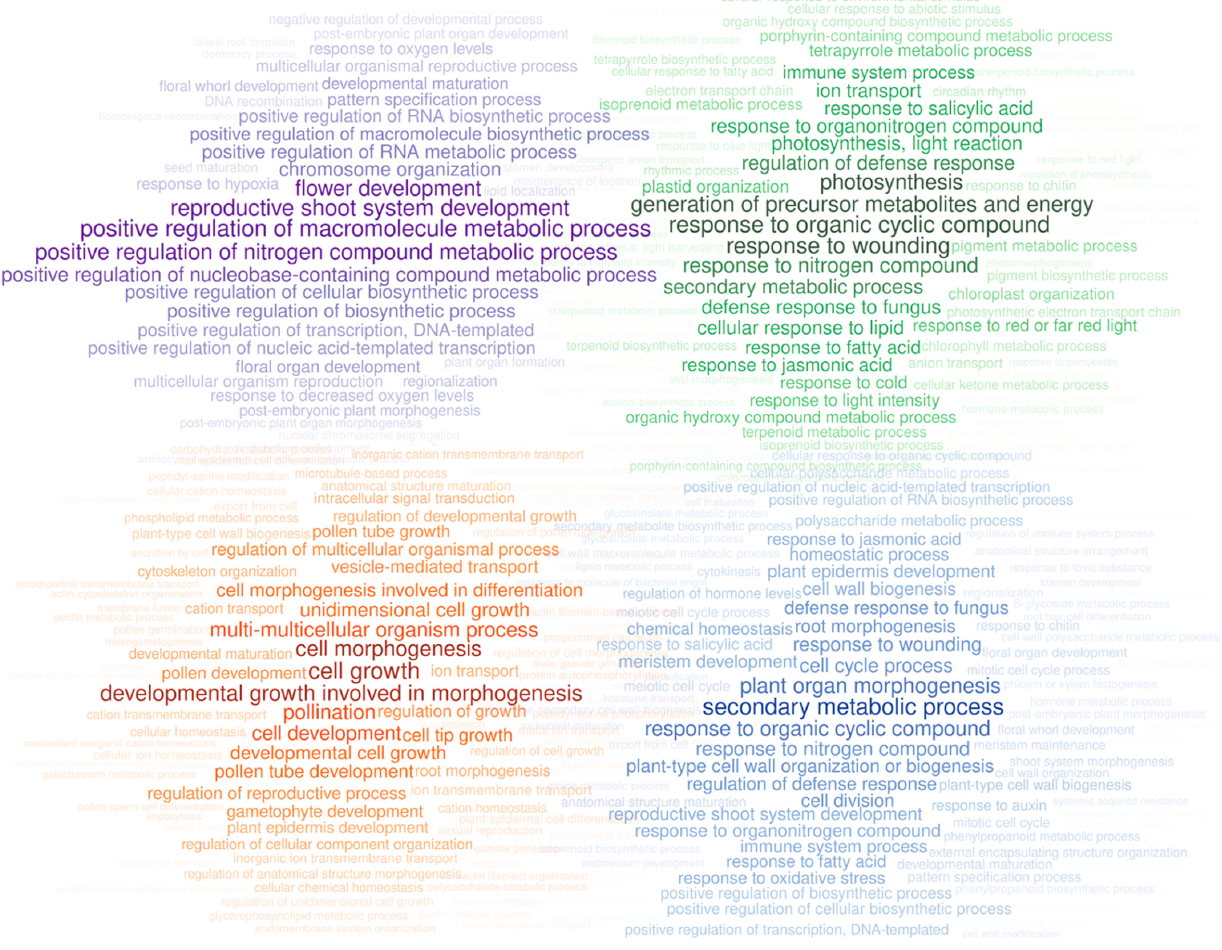
Figure 3. Enriched biological processes in specific genes of seeds ( top-left , in purple), leaves ( top- right , in green), pollen ( bottom-left , in orange), and roots ( bottom-right , in blue). Word size and color opacity represent the frequency of the terms found in the enrichment analysis.